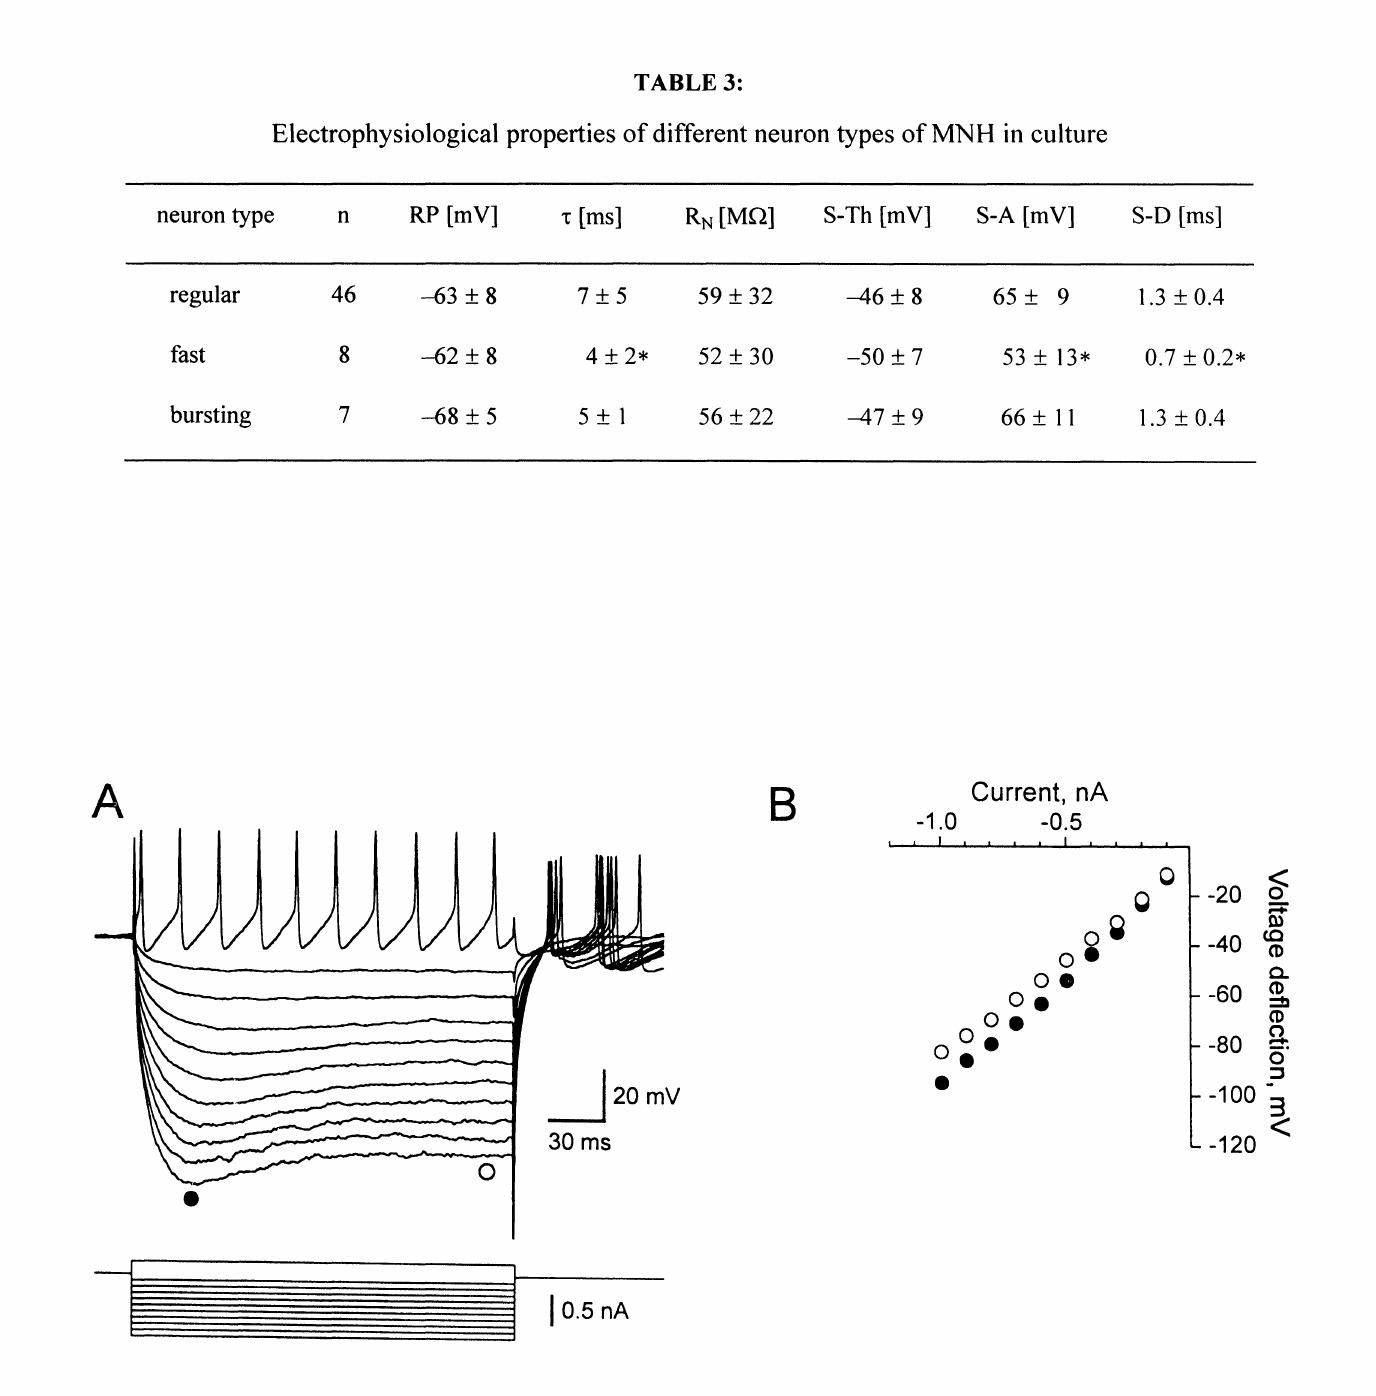
Fig. 5: Fast spiking MNH neuron with inward rectifier characteristics. A: Superimposed neuronal responses during one depolarizing and ten hyperpolarizing intracellular current pulses. An initial overshoot ("sag") of the membrane deflection at the beginning of the pulse is visible (filled circle). Current steps are indicated below. B: Current-voltage relationship. The amplitudes of membrane voltage deflections were measured at the beginning of the current pulse (filled circle) and at the end (open circle). The divergence ofthe two curves indicates the presence of an inward rectifier